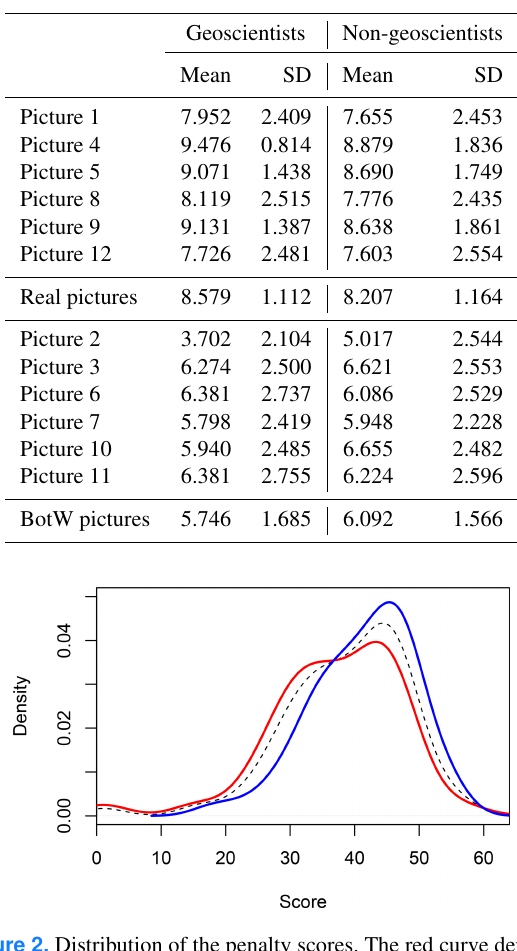
Figure 2. Distribution of the penalty scores. The red curve denotes the geoscientists, the blue one the non-geoscientists. The dashed black curve shows the density for the whole